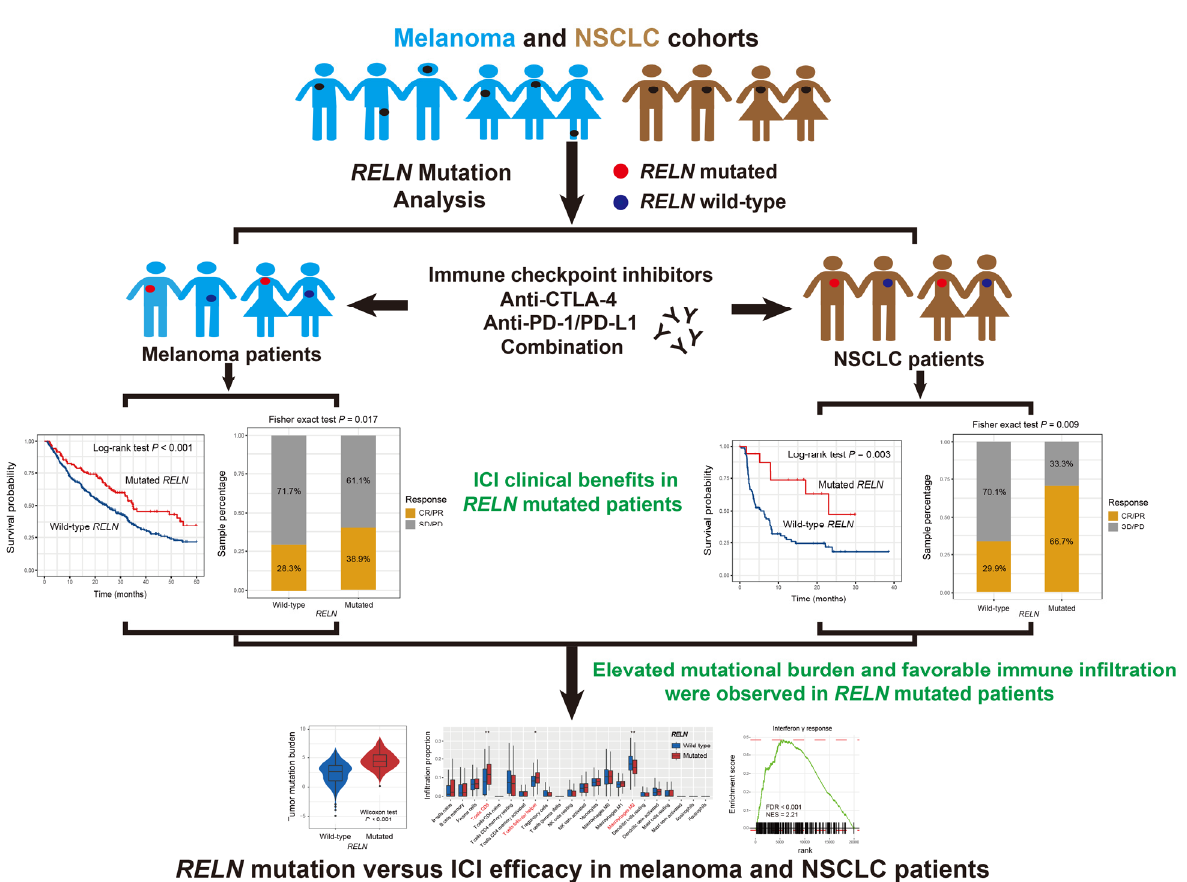
Figure 1. The detailed workflow operating in this work to explore the clinical ICI treatment implications of RELN mutations based on the genomic data and immunotherapy information.